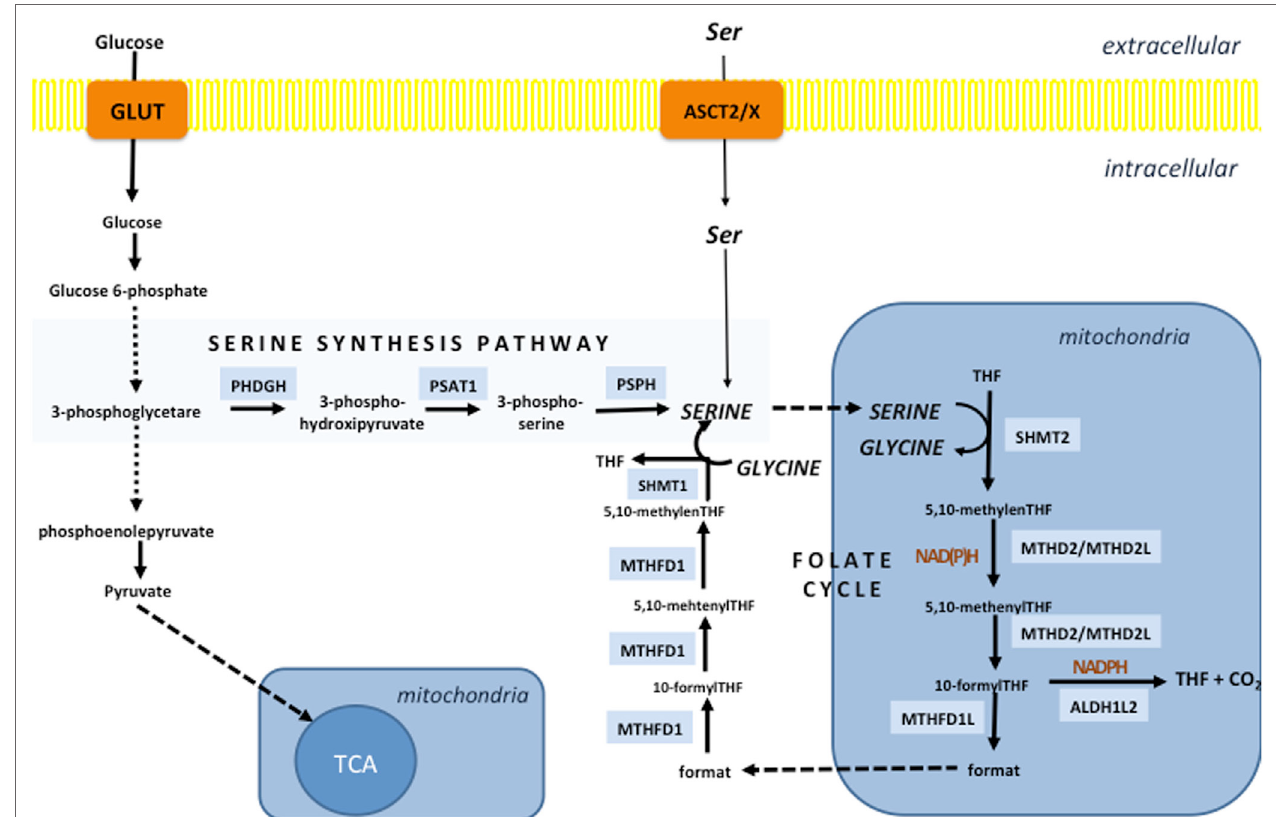
FiGURe 3 | The folate cycle is fueled by the serine synthesis pathway (SSP) and extracellular serine. SSP diverges from glycolysis at the level of 3-phosphoglycerate, which is converted into 3-phospho-hydroxipyruvate by the action of the enzyme phosphoglycerate dehydrogenase (PHDGH) and ultimately to serine following further enzymatic steps. This pathway is of great importance in cancers with mutated or overexpressed PHDGH, while serine import plays a pivotal role in maintenance of the serine cellular balance in cells with unaltered PHDGH activity. The folate cycle in the vast majority of the cells starts in mitochondria by the action of serine hydroxymethyl transferase 2 (SHMT2) which generates glycine and 5,10-methylene-tetrahydrofolate (5,10-methylene-THF). The next reaction can produce NADH or NADPH depending if methenyltetrahydrofolate dehydrogenase 2 (MTHD2) or MTHD2-like (MTHD2L) is used to convert 5,10-methylene-THF into 5,10-methenyl-THF. The same enzyme than generate one-carbon unit—10-formyl-THF, which can be used for ATP production by the enzyme (MTHD1L) or NADPH generation in the reaction catalyzed by 10-formyTHF dehydrogenase (ALDH1L2). If ATP is generated, 10-formylTHF is converted into a format that is transported into the cytosol and used by trifunctional MTHFD1 enzyme to regenerate 10-formylTHF for purine synthesis, 5,10-methylene-THF for thymidylate synthesis and homocysteine remethylation in the methionine cycle. The unidirectionality of the folate cycle seems to be provided by more oxidative mitochondrial redox state that favors use of NAD(P) + by mitochondrial